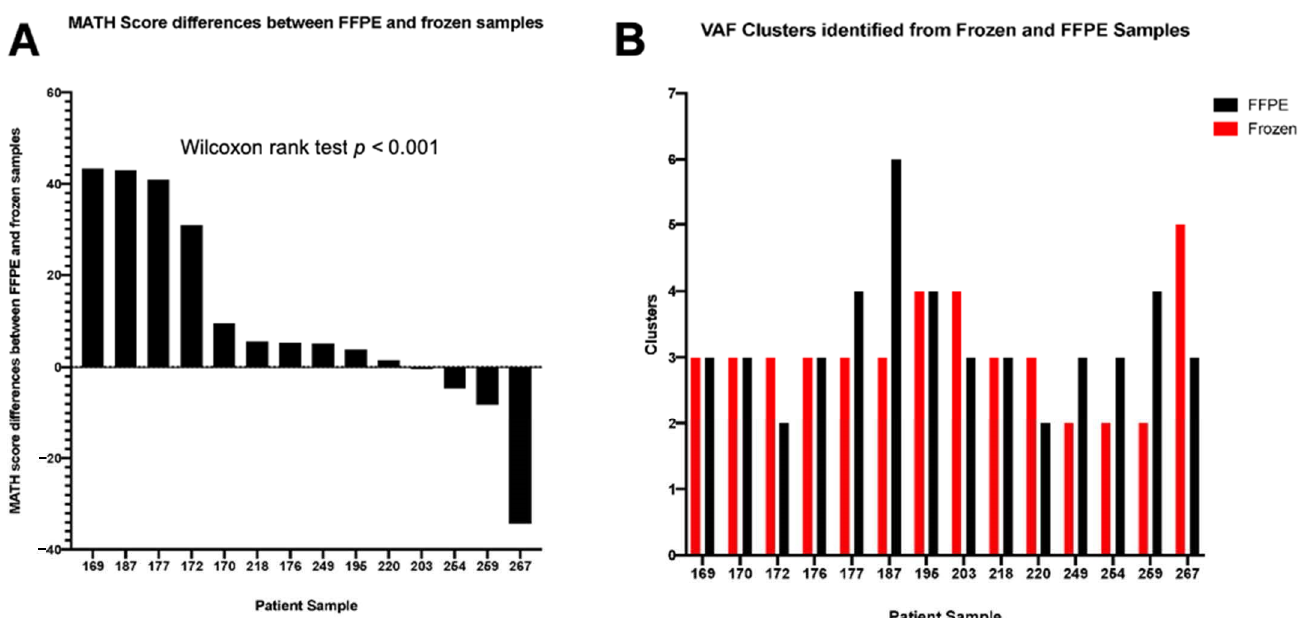
Figure 3. Differences in mutant-allele heterogeneity (MATH) scores and variant allele frequency (VAF) clusters identified from matched formalin-fixed paraffin-embedded (FFPE) and frozen gastro-oesophageal tumours. Histogram illustrating ( A ) differences in MATH scores between FFPE and frozen tumour samples—11 out of 14 FFPE tumours had higher MATH scores when compared with the corresponding frozen tumours ( p < 0.001 Wilcoxon rank test); and ( B ) VAF clusters identified from FFPE and frozen samples.